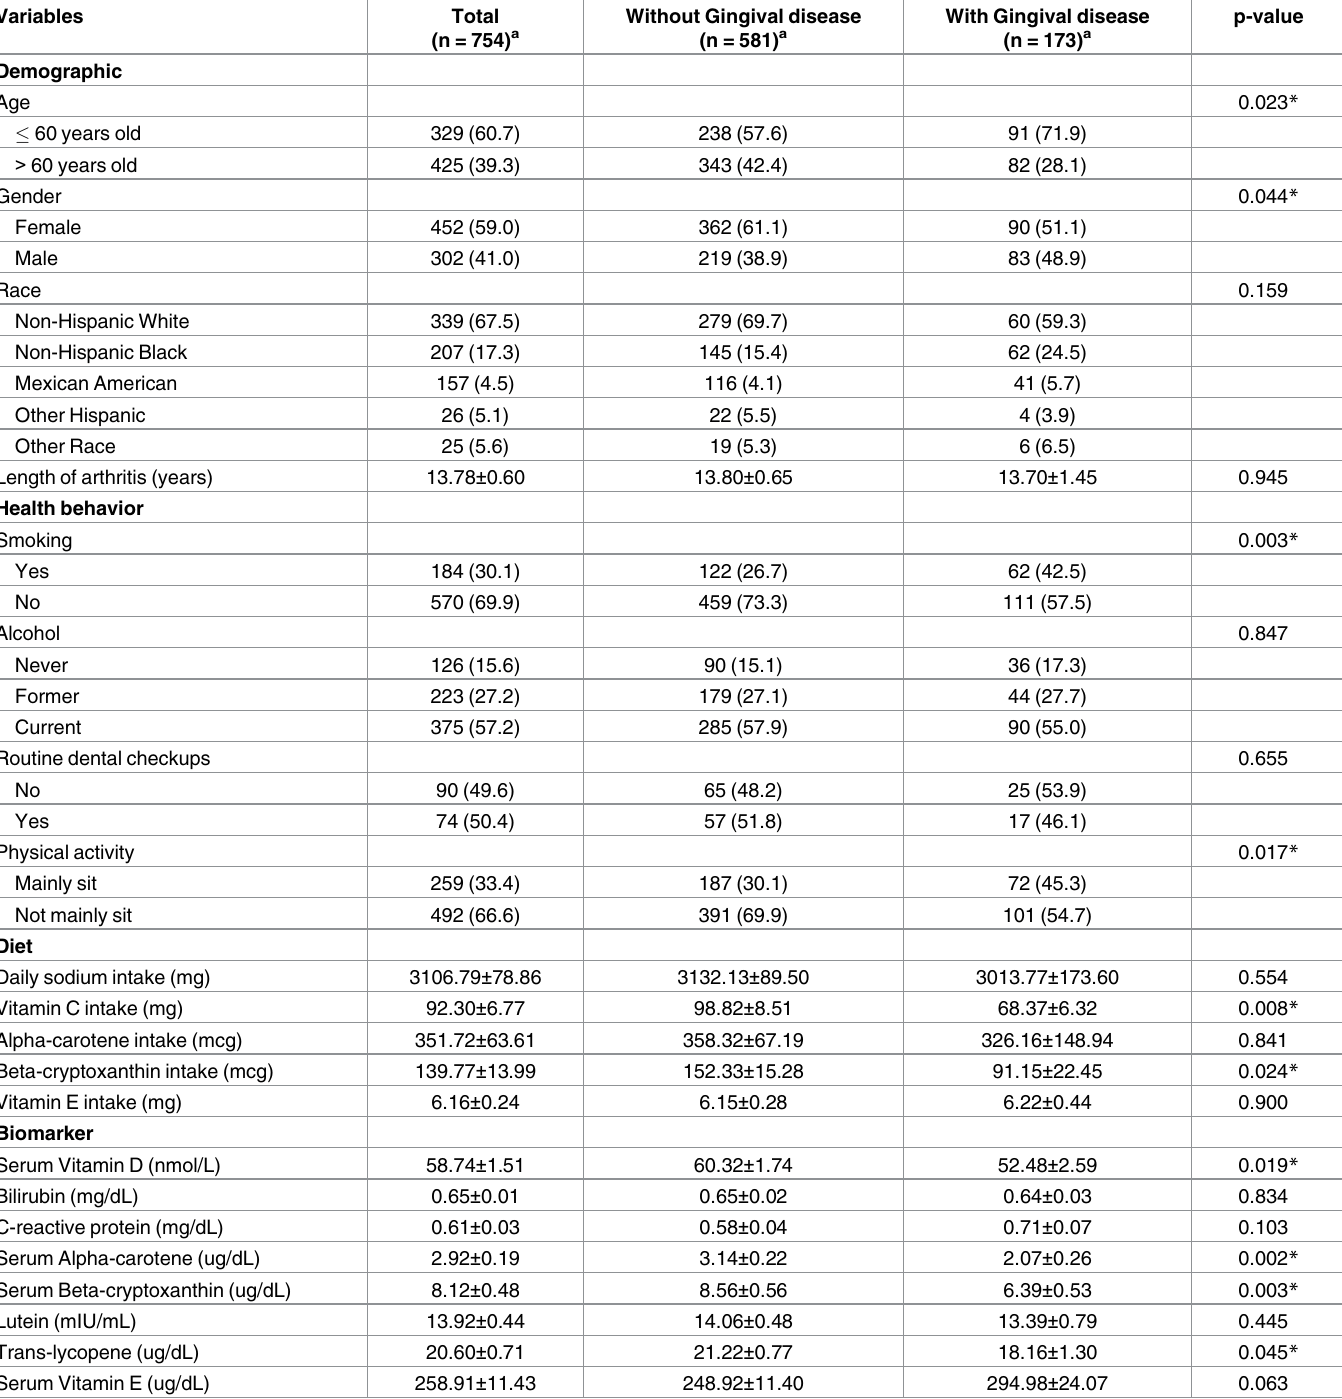
Table 1. Demographics and dietary characteristics of study participants (Unweighted n = 754, Weighted N =